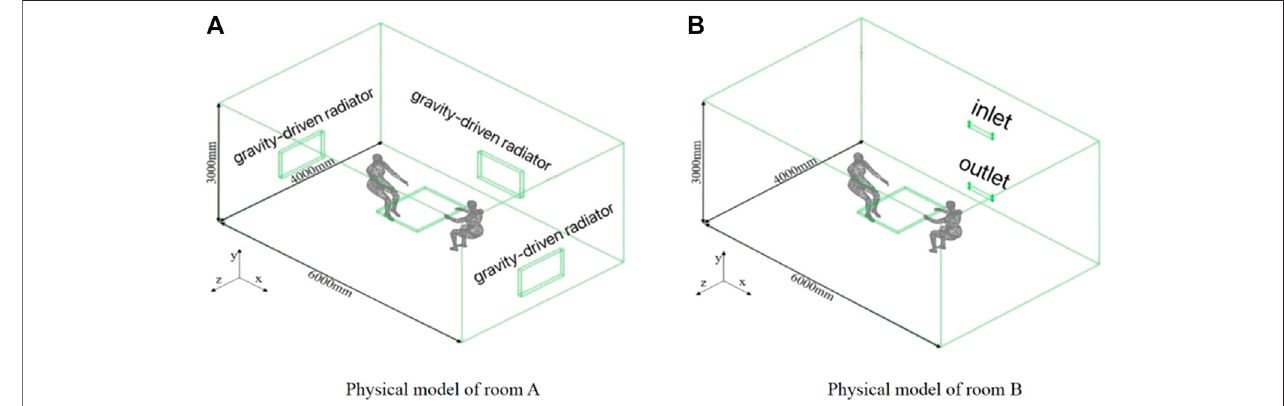
FIGURE 7 | Physical model of the heating room.